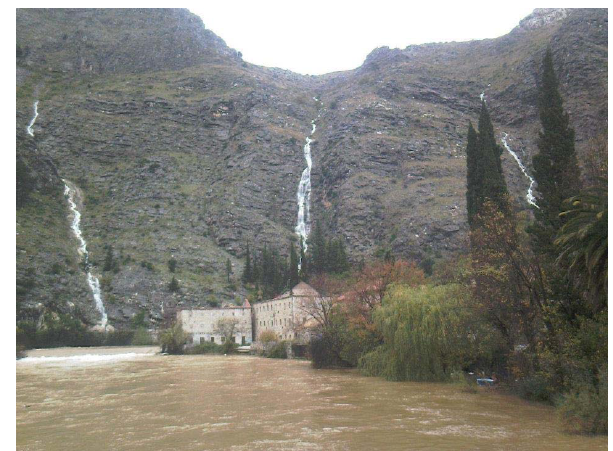
Figure 9 Fig. 9. Photograph of GWL overflow through three fossil karst con- duits on 22 October